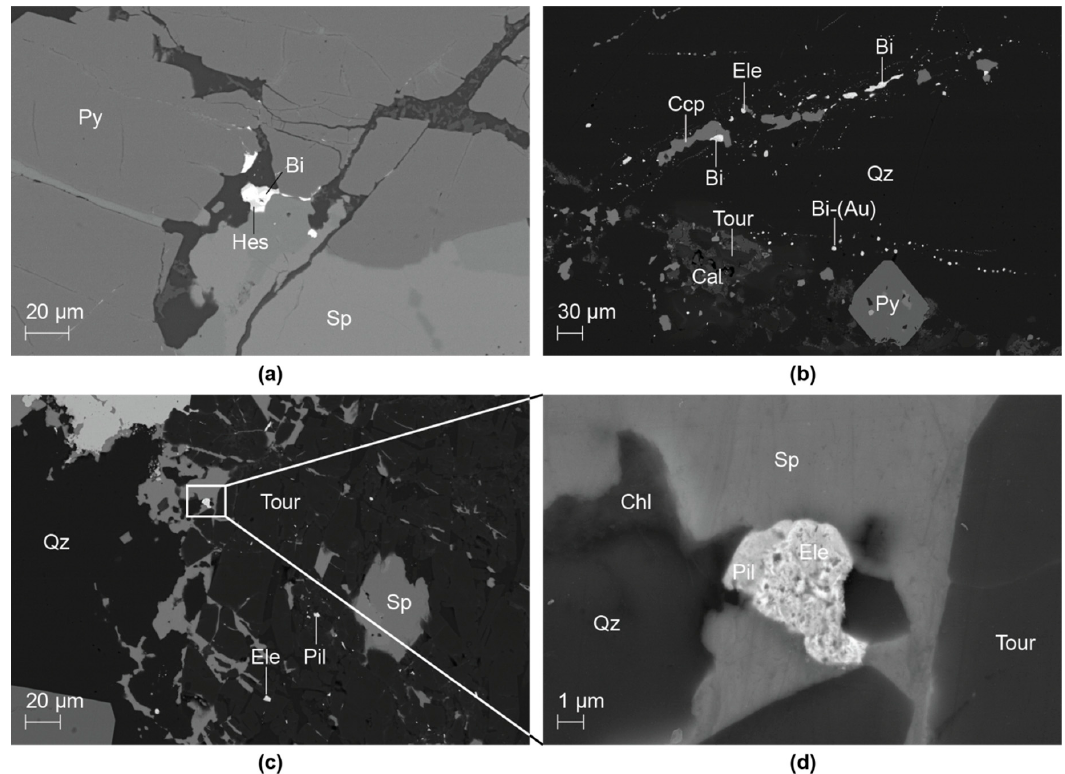
Figure 3. Backscattered ( a – c ) and secondary ( d ) electron images of the thin section prior to QEMSCAN ® analysis; ( a ) intergrowth of native Bi and hessite in a crack between grains of pyrite and sphalerite; ( b ) droplet-shaped grains of native bismuth with Au in quartz; ( c ) grains of electrum at the border of sphalerite and tourmaline, respectively; ( d ) magnified image of (c). Abbreviations: